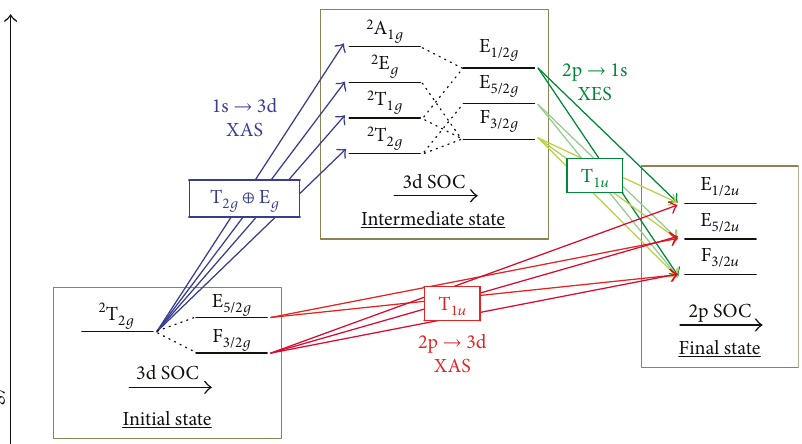
Figure 22: Multielectronic term scheme for Ti 3+ ( 3d 1 ) comparing the 1s2p RIXS and direct 2p XAS pathways. Where SOC is included, the spin multiplicity is omitted as its meaning is lost in that